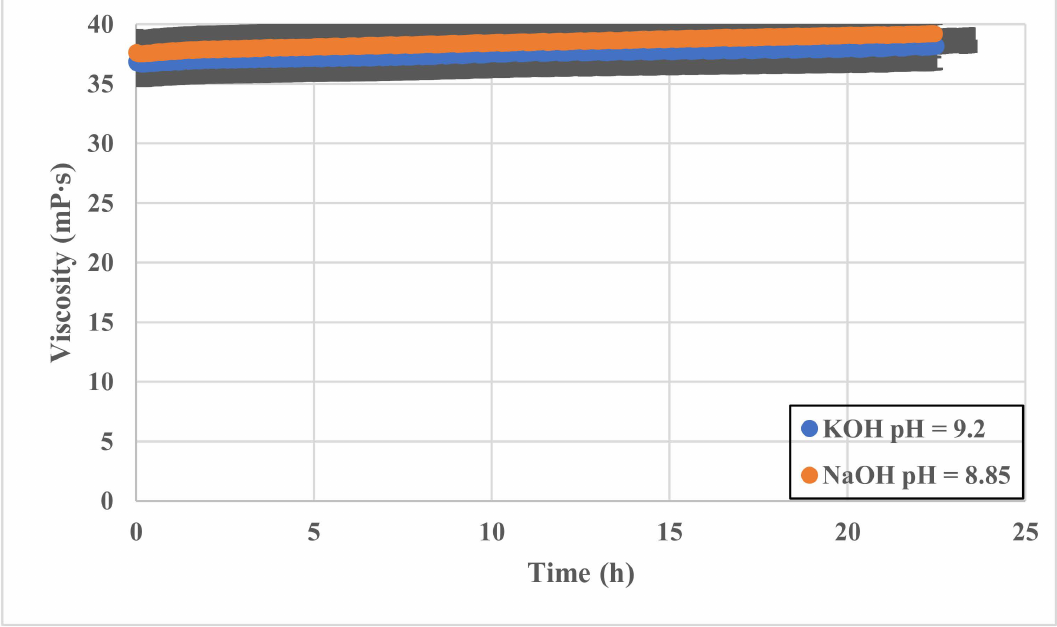
Figure 5. Rheology comparison for different pH controllers added to